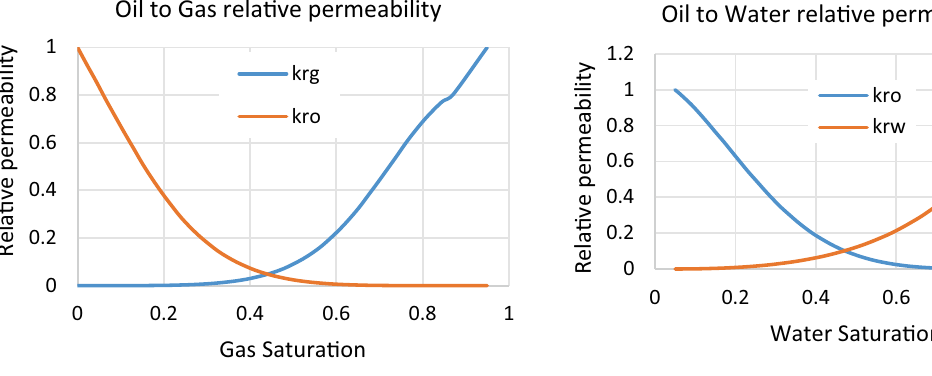
Fig. 13 Relative permeability curves used in material balance model